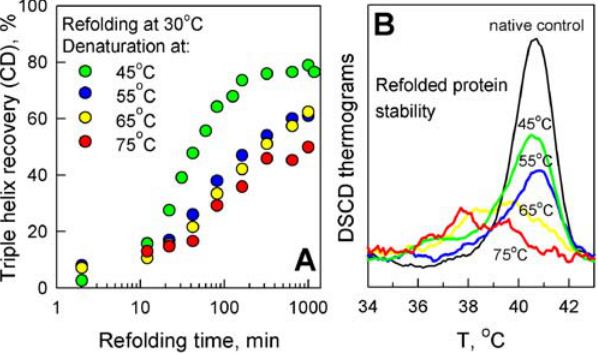
Figure 4. Native structure of procollagen triple helix spontaneously refolds at 30 u C after mild denaturation. A. Kinetics of triple helix recovery at 30 u C monitored by CD at 223.8 nm in 0.1 mg/ml procollagen solution in PBS after 10 min denaturation at indicated temperatures. B. DSCD thermograms (0.05 u C/min) of a native control sample and the refolded procollagen solutions after 10 hour equilibra- tion. The native control has a single, narrow peak at , 41 u C. Additional peaks at lower temperature in the refolded samples originate from shorter, less stable, gelatin-like helices.